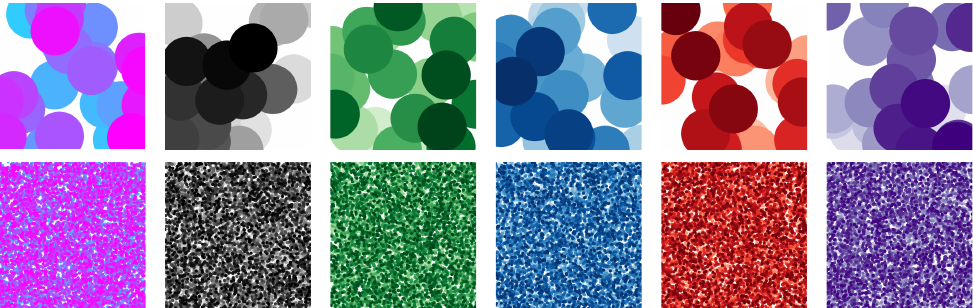
Figure 2. The generated texture pattern for the cube objects. The upper row corresponds to the objects designed for the scenarios of low accuracy, whereas the lower row regards the scenarios of high accuracy. The color was an uninformative feature for the task and was used to diversify the